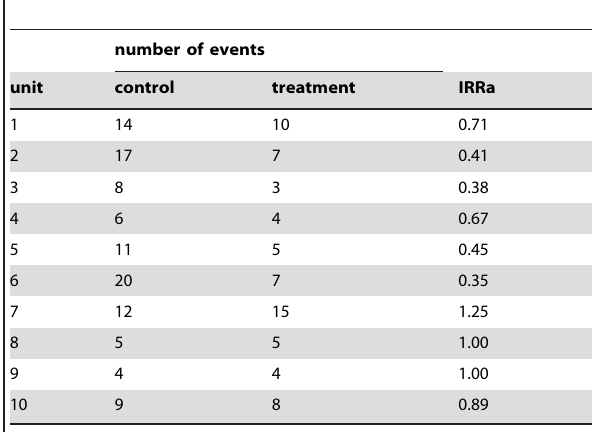
Table 2. One of the 1000 Simulated data